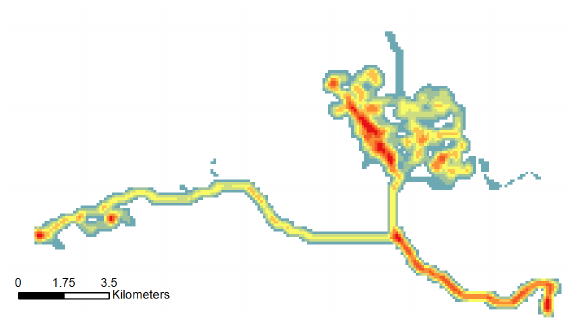
Figure 12: Generalisation of grid-masked trajectories - KDE for the trajectories derived using grid-based-masking.